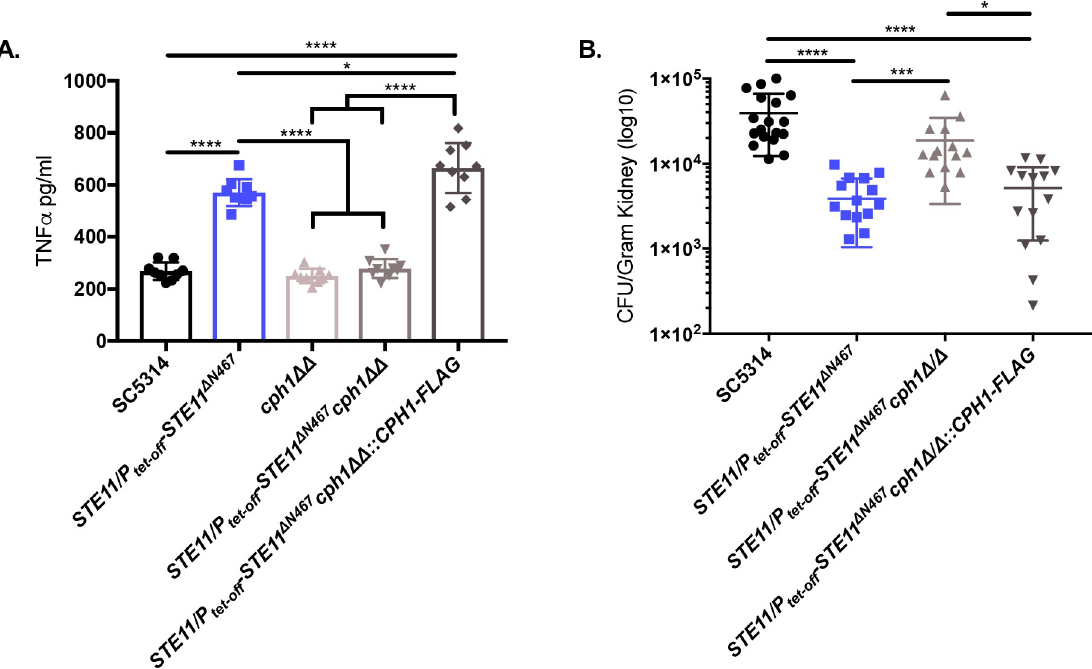
Fig 5. CPH1 deletion reduces Ste11 Δ N467 induced TNF α secretion by macrophages and partially restores virulence during systemic infection in mice. (A) TNF α secretion by RAW264.7 macrophages. RAW264.7 murine macrophages and UV-inactivated C . albicans strains were co-incubated for 4 hours at a multiplicity of infection (M.O.I.) of 10. Culture supernatant was subsequently filtered through a 0.22 μ m filter and assessed via ELISA analysis to determine secreted TNF α levels. ( � p = 0.0063, ���� p < 0.0001, by one-way ANOVA with Tukey’s post hoc analysis)(n = 3 biological replicates with 3 technical replicates for each sample). (B) Kidney fungal burden 4 d.p.i. during infection with cph1 ΔΔ mutants. ICR mice were intravenously injected with 1x10 6 cells of C . albicans wild-type (SC5314), STE11/P tet-off - STE11 Δ N467 , STE11/P tet-off -STE11 Δ N467 cph1 ΔΔ or the STE11/P tet-off -STE11 Δ N467 cph1 ΔΔ :: CPH1-Flag strain and kidneys were harvested 4 d. p.i to assess fungal burden. (n = 7–8 mice)( � p < 0.05, ��� p < 0.001, ���� p < 0.0001, by Kruskal-Wallis test with Dunn’s multiple comparisons post-hoc